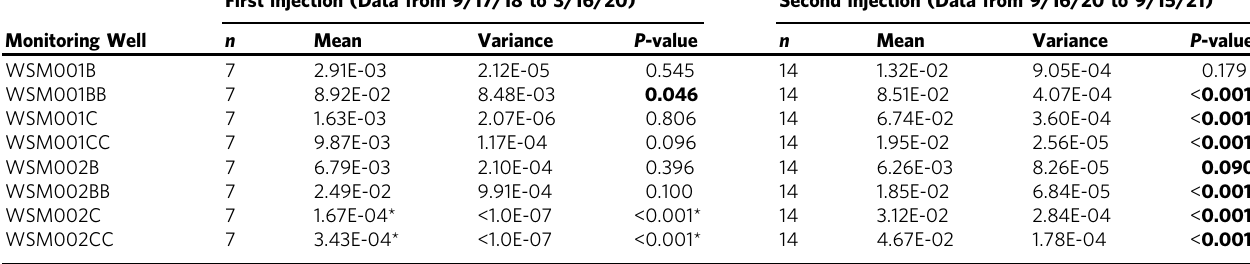
Table 2 Results of statistical testing of pre- and post-injection total mercury concentrations ( n = number of analyses) Hg t -test: two tail assuming unequal variances Hg baseline n = 61; mean = 1.789E-03 µ M; variance = 3.47E-06 µ M tabulated means and variances in units of µ M.